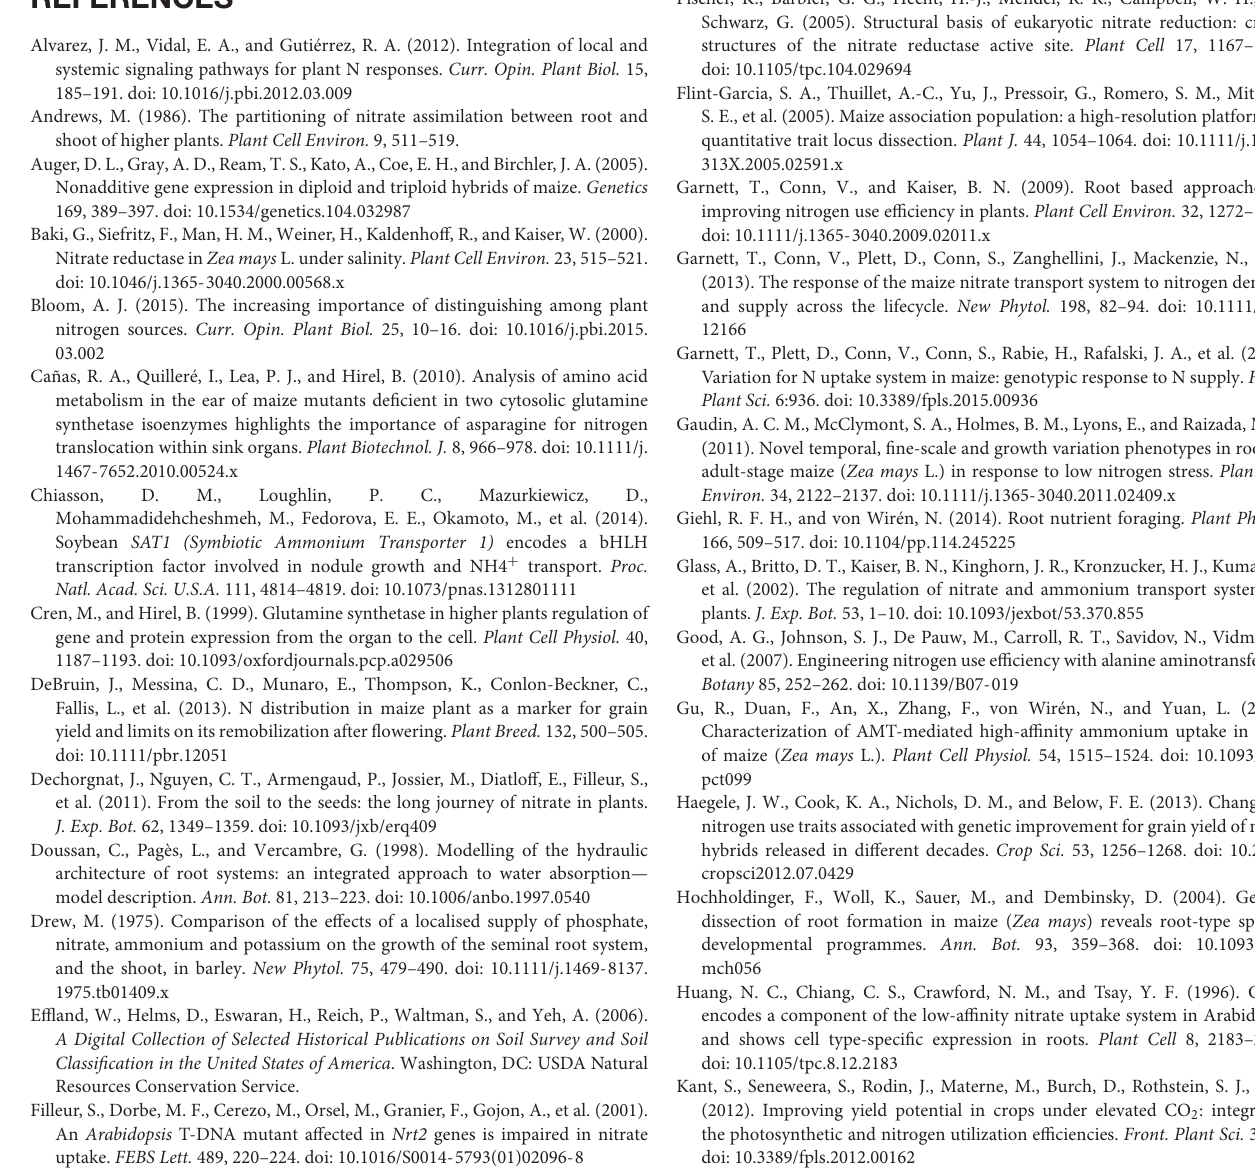
FIGURE S3 | Comparison of BK3 (gray) seminal (A) and primary (B) root phenotypes with the parents B73 (white) and F44 (black). The data were normalized to B73. Values are means ( ± SE) from five individual plants. Asterisks indicate significant differences with B73 at ∗ P < 0.05, ∗∗∗ P < 0.005 (Student’s t -test). FIGURE S4 | Expression of nitrogen transporter and metabolism pathway genes in B73 (white), BK3 (gray) and F44 (black) roots. The data were normalized to B73. Values are means ( ± SE) from three individual plants. Similar results were obtained in another independent experiment. Asterisks indicate significant differences with B73 at ∗ P < 0.05, ∗∗∗ P < 0.005 (Student’s t -test). (NPF/NRT, nitrate transporter; AMT, ammonium transporter; GLN, glutamine synthetase; NIR, nitrite reductase; TABLE S1 | List of genes studied in this